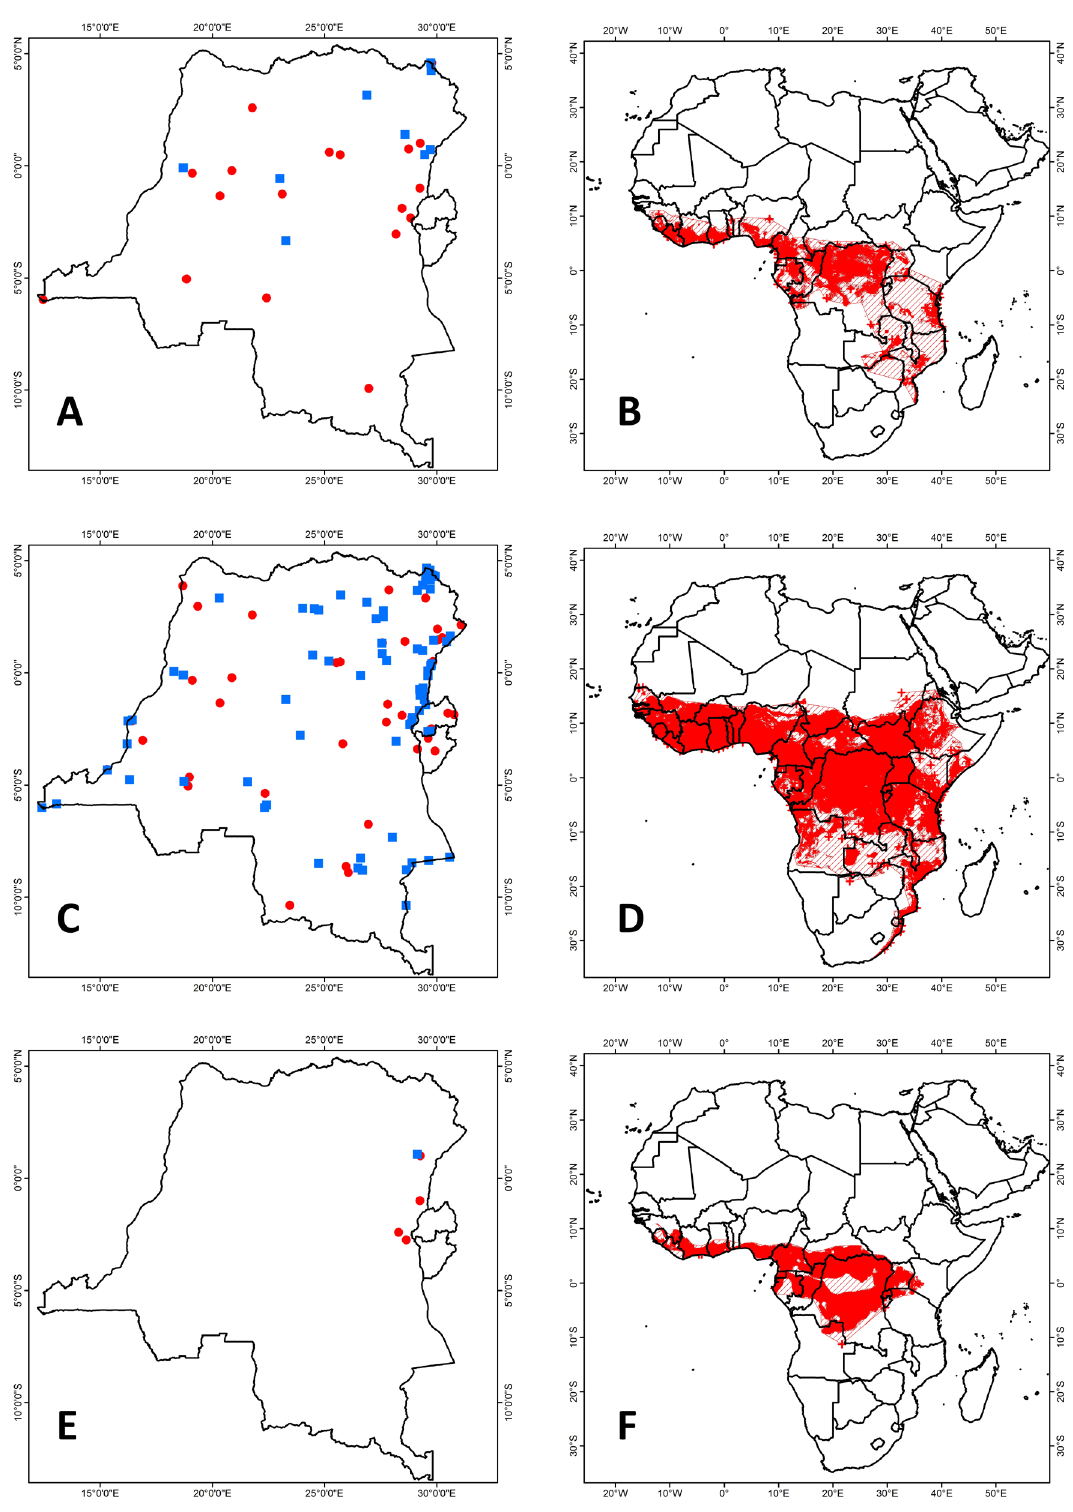
Fig. 21. Distribution maps. A–B . Nycteris grandis Peters, 1865. C–D . Nycteris hispida (Schreber, 1774). E–F . Nycteris intermedia Aellen, 1959. A, C, E. Distribution in the CRB area. B, D, F. Pan-African